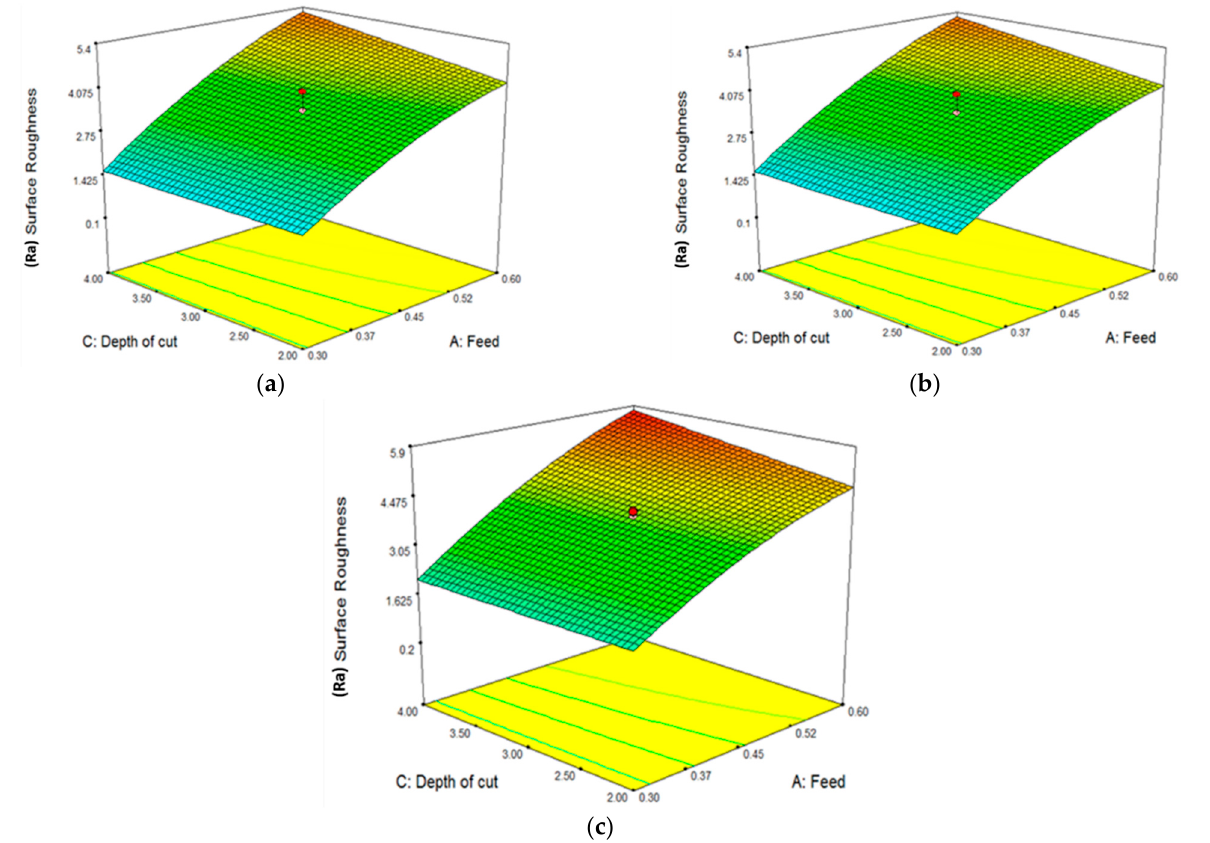
Figure 4. ( a ) 3D Graph for feed vs. depth of cut (level 1), ( b ) 3D graph for feed vs. depth of cut (level 2), and ( c ) 3D graph for feed vs. depth of cut (level 3).